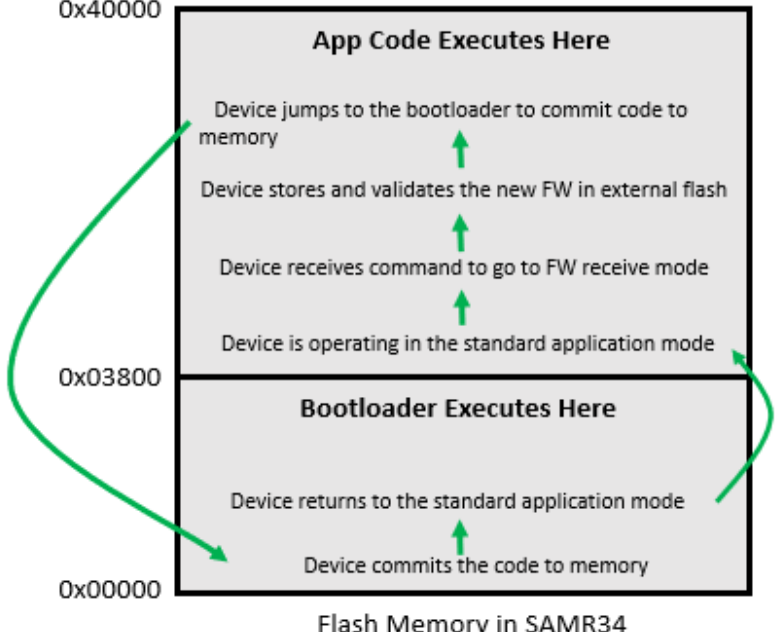
Figure 5. Flash memory breakdown for using external